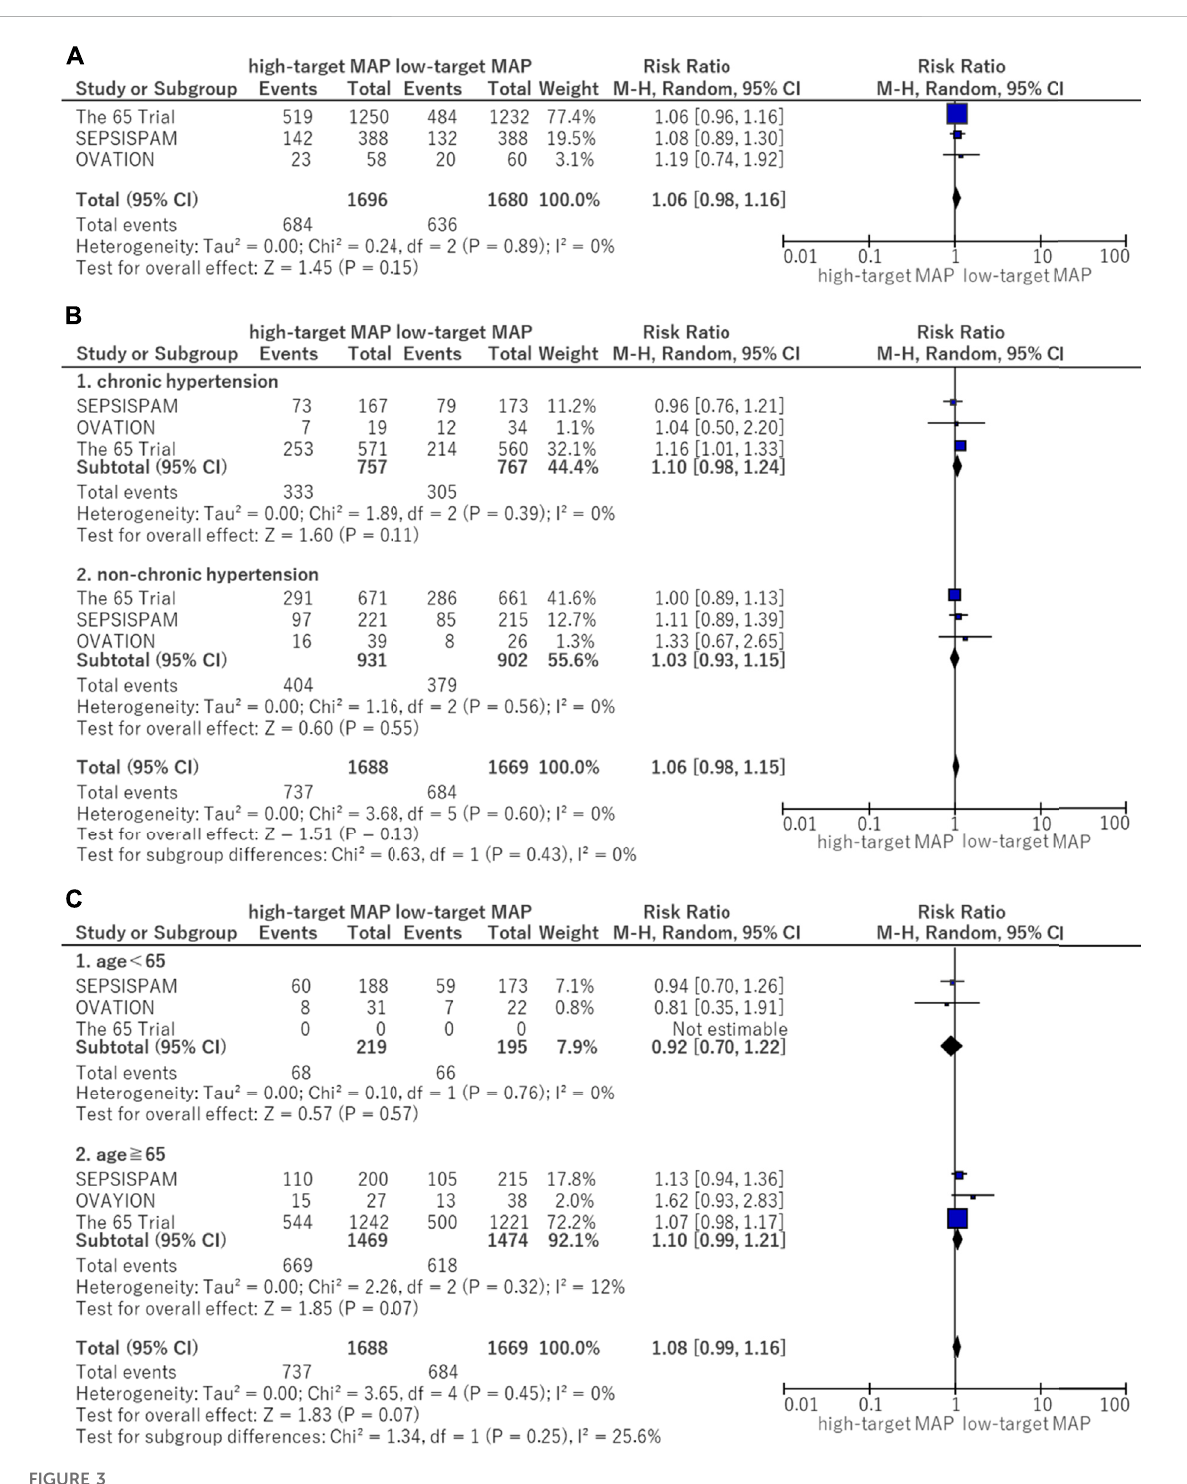
FIGURE 3 Forest plot of the comparison of a higher MAP versus lower MAP: Mortality. (A) All-cause mortality (closestto 28 days). (B) Mortality for patients with chronic hypertension. (C) Mortality for age < 65 and S 65. CI, con fi dence interval; M-H, Mantel – Haenszel; MAP, mean arterial